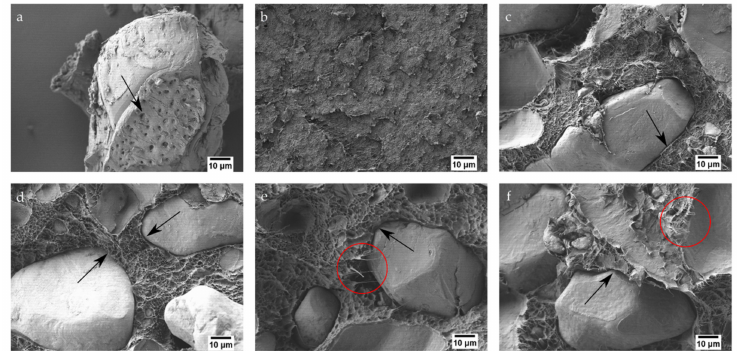
Figure 3. Field emission scanning electron microscopy (FESEM) images at 1000 × of the fractured surfaces of: ( a ) MAS; ( b ) neat Bio-HDPE; ( c ) Bio-HDPE/PE-g-MA/MAS; ( d ) Bio-HDPE/PE-g-MA/MAS/HNTs; ( e ) Bio-HDPE/PE-g-MA/MAS/MLO; ( f ) Bio-HDPE/PE-